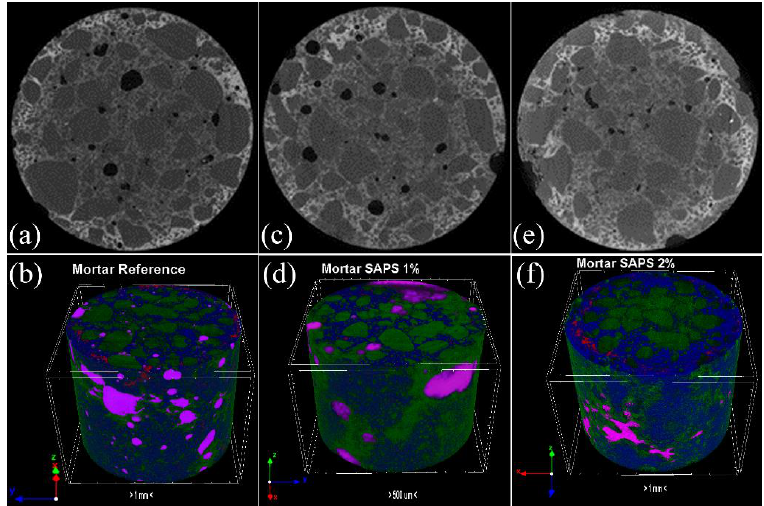
Figure 2. 2D and 3D reconstructed images of the scanned specimens of: mortar-reference ( a , b ); mortar-SAPs-1% ( c , d ); mortar-SAPs-2% ( e , f ).